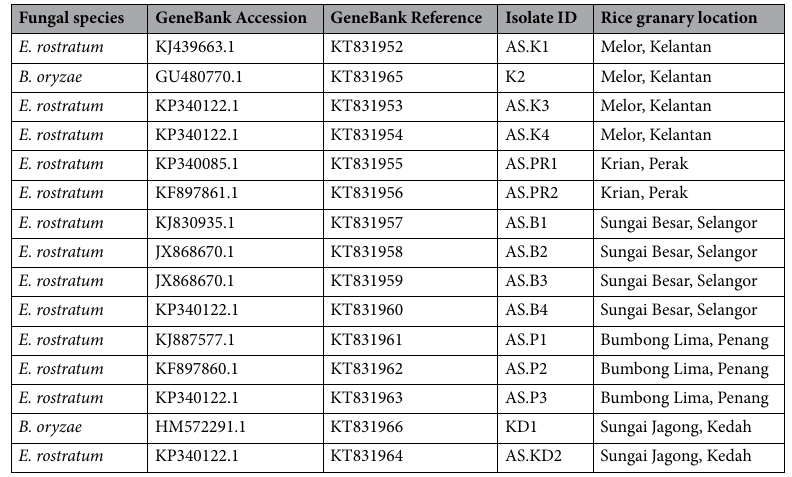
Table 1. Brown spot causal agents isolated from rice granaries in Peninsular Malaysia. The isolate and GeneBank Accession of the internal transcribed fungal (ITS) sequences are expressed at > 99% similarity